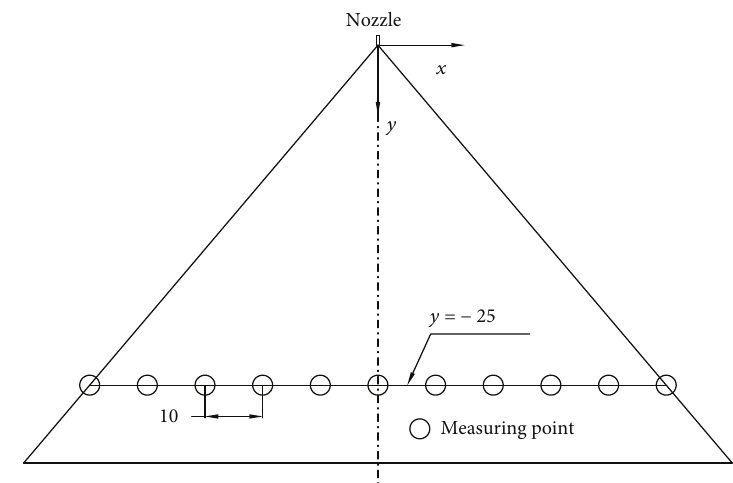
Figure 18: The measuring point position of the spray body.